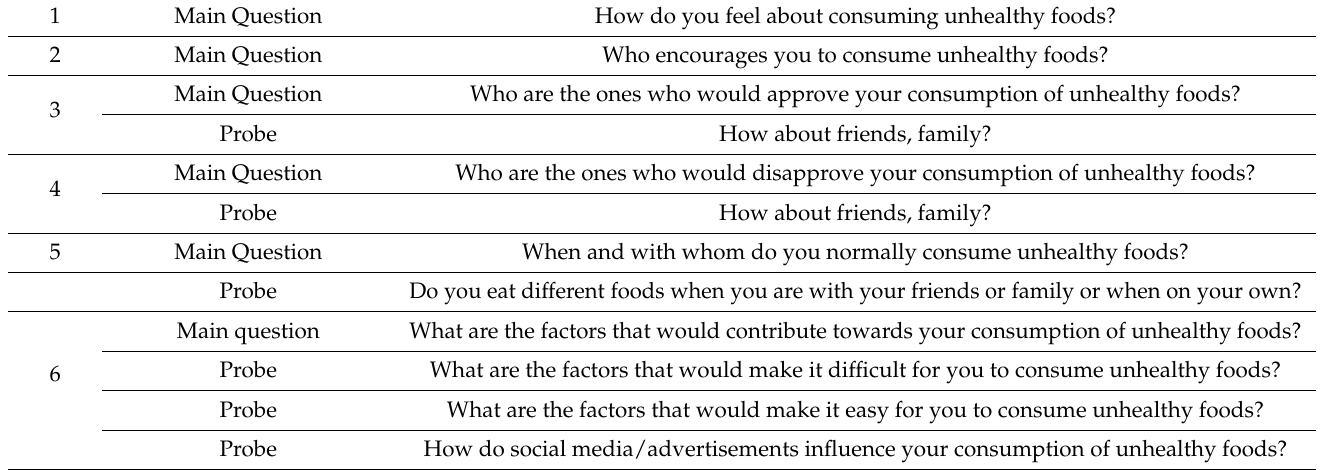
Table 1. Interview